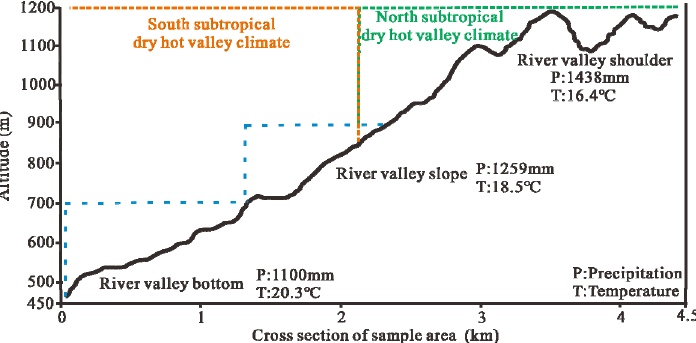
Figure 7. Diagram of the vertical variation of the climate of Huajiang dry ‐ hot valley.